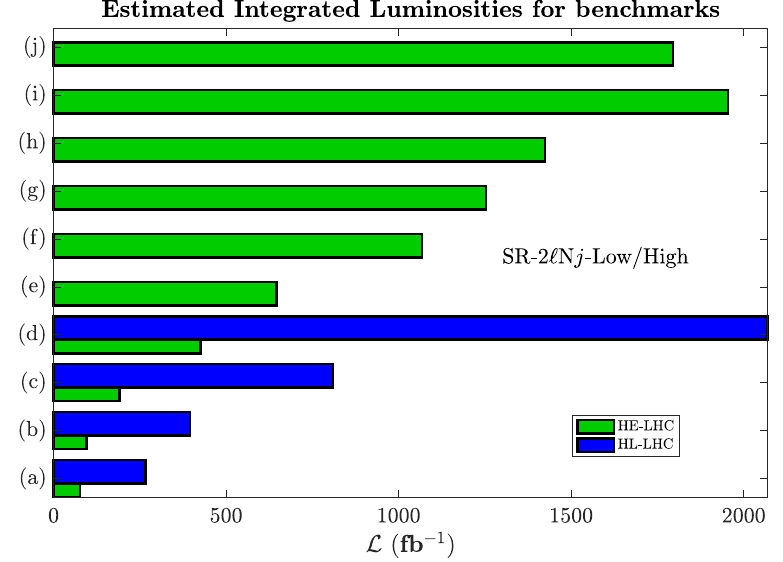
Figure 8. Estimated integrated luminosity for discovery of benchmarks of table 1 at 14 TeV and 27 TeV. Only four benchmarks are discoverable at HL-LHC while all ten points are visible at HE-LHC. In the (cid:12)gure SR-2 ‘ Nj-Low/High are de(cid:12)ned as in table